Question: Summarize what this figure shows in one sentence.
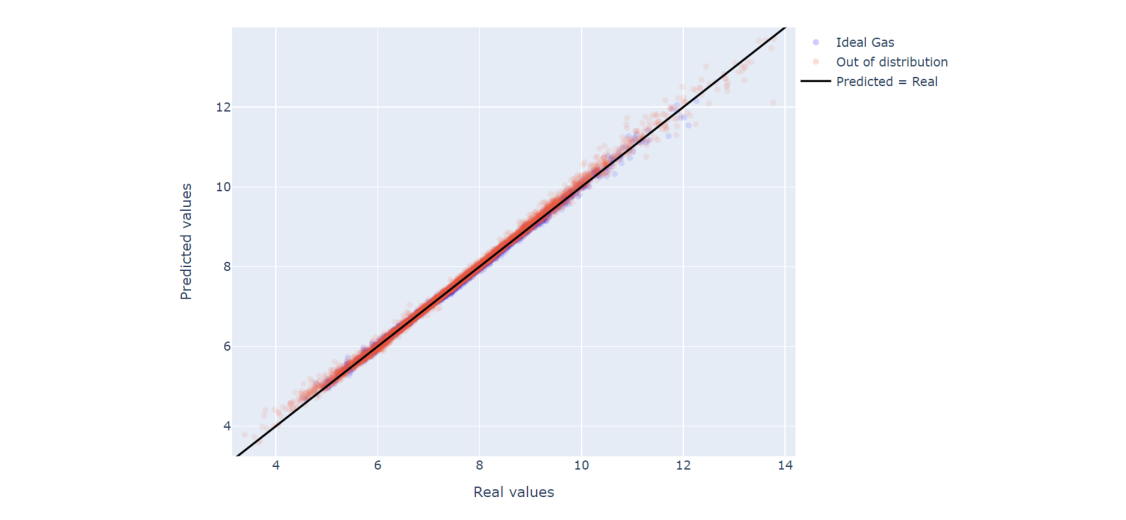
Answer: Predicted vs. Real Pressure, Experiment 2